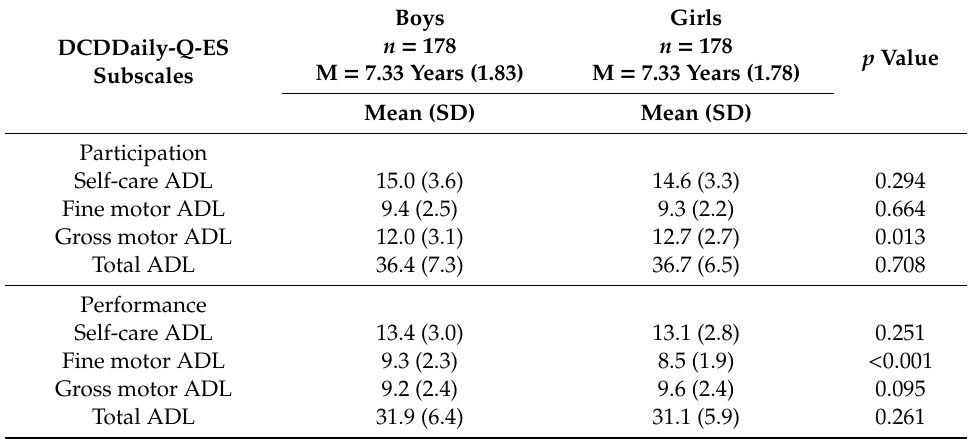
Table 3. Di ff erences in DCDDaily-Q-ES subscales and total scores for participation and performance in ADL across sex ( n = 356).